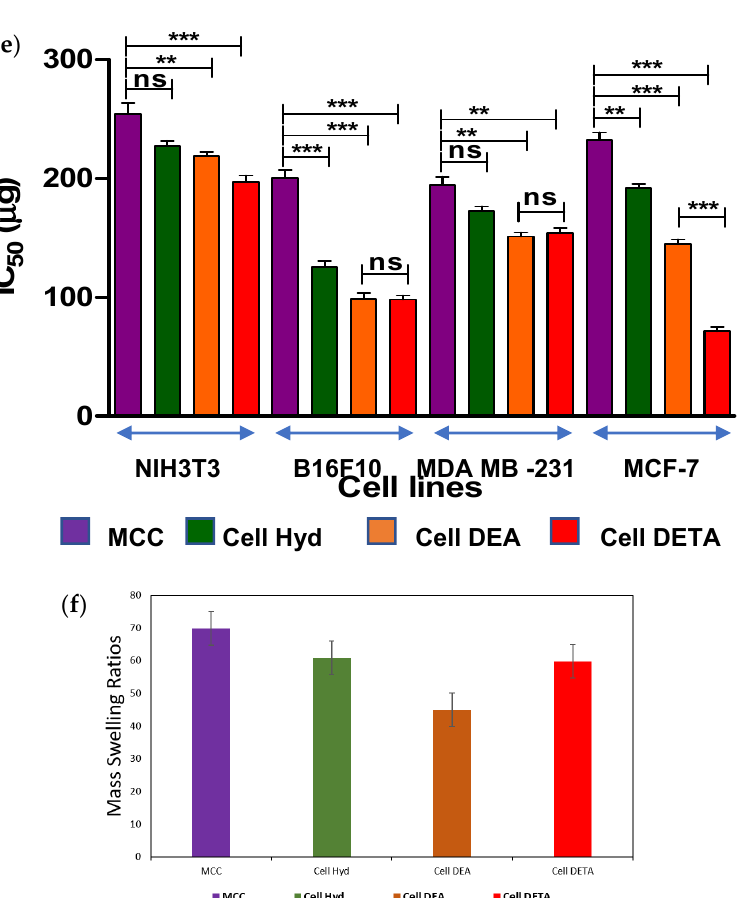
Figure 4. Cell Culture Evaluating the IC 50 values for the Cellulose and its derivative MCC, Cell Hyd, Cell DEA and Cell DETA ± average standard deviation (* p < 0.05, ** p < 0.01, and *** p < 0.001) against Normal. ( a ) NIH3T3 and Cancer cell lines. ( b ) B16F10. ( c ) MDA-MB-231. ( d ) MCF-7. ( e ) IC50 values graph. ( f ) Swelling ratios of cell derivatives. Table 3. IC 50 values for different cell lines.